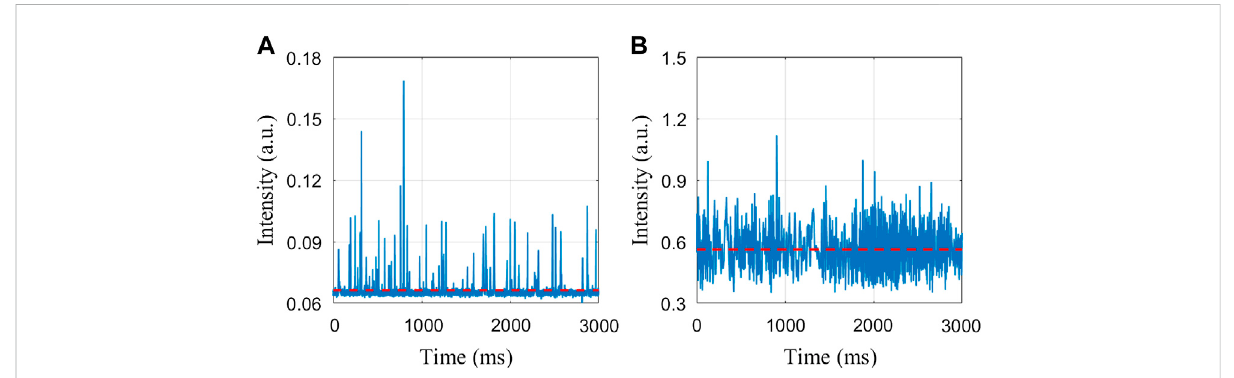
FIGURE 2 Measured signals of PM in (A) low concentration and (B) high concentration.